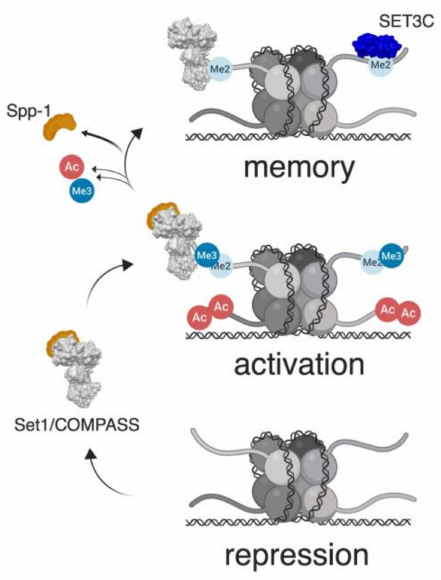
Figure 1. Model for S. cerevisiae INO1 transcriptional memory. When INO1 transcription is repressed (lower panel), nucleosomes associated with the INO1 promoter are hypoacetylated and hypomethylated. Upon activation (middle panel), INO1 relocalizes to the nuclear periphery, promoter nucleosomes are acetylated, and Set1/COMPASS di- and tri-methylates H3K4. When memory is induced (upper panel), INO1 remains at the nuclear periphery, nucleosomes are deacetylated, and a remodeled version of Set1/COMPASS (lacking the Spp1 component required for H3K4 tri-methylation) leads to the accumulation of H3K4me2, which is maintained through its interaction with the SET3C histone deacetylase